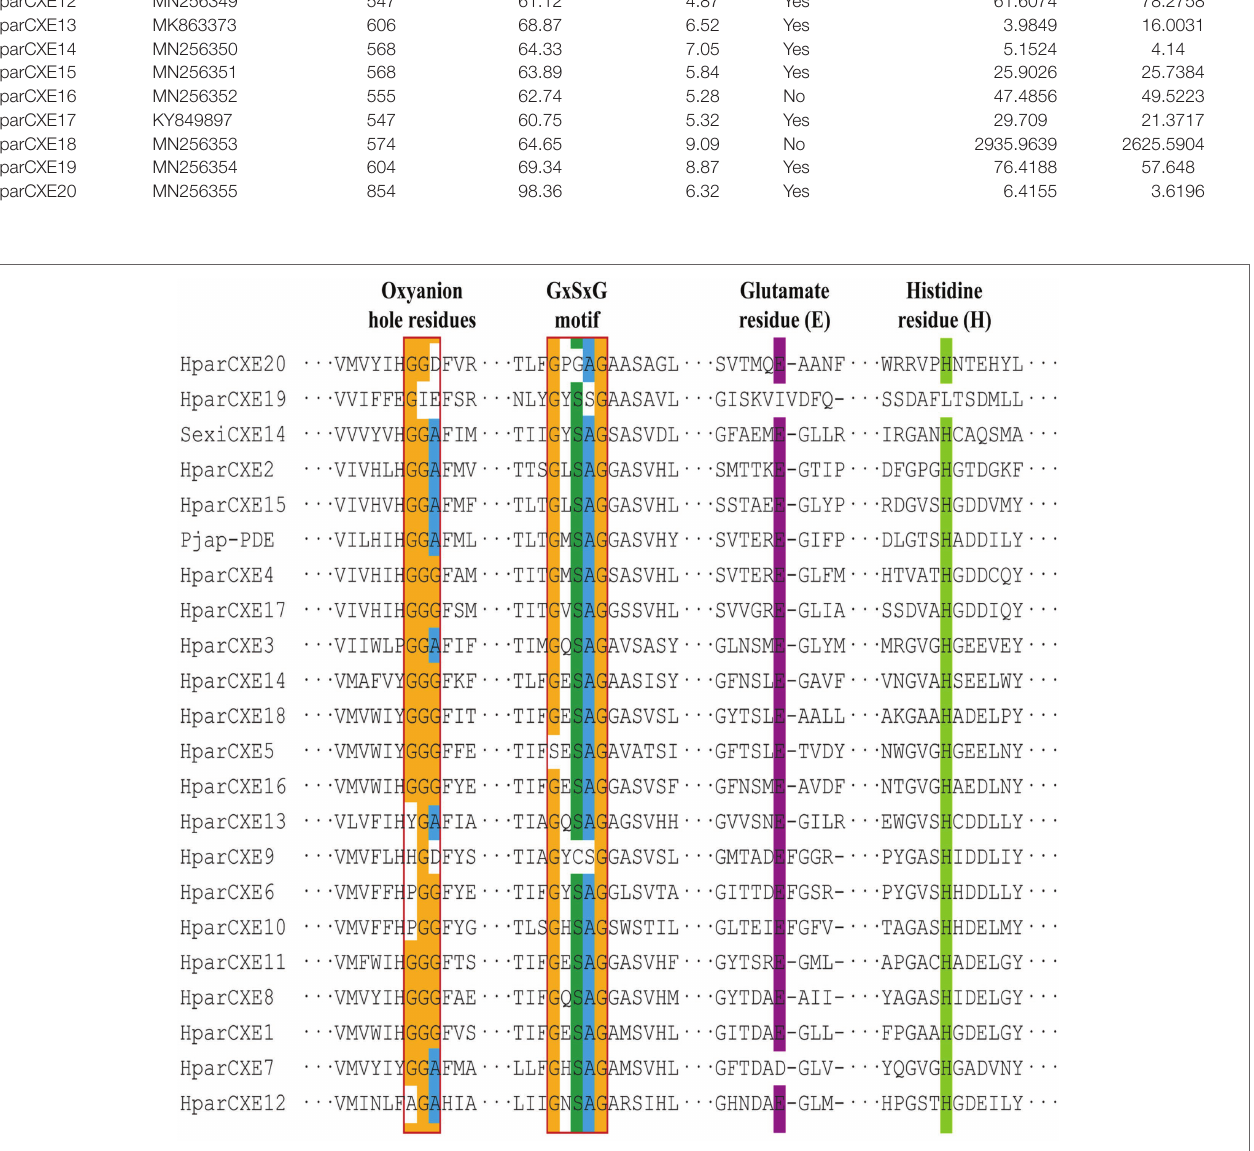
FIGURE 1 | Alignments of amino acid sequences of carboxylesterases (CXEs) from Holotrichia parallela and other insect species. The reference amino acid sequences are from S. exigua (Sexi) and Popilia japonica (Pjap). Amino acids not shown here are represented by three sequential dots. The Gly-X-Ser-X-Gly motif and the oxyanion hole-forming residues (Gly, Gly Ala) are